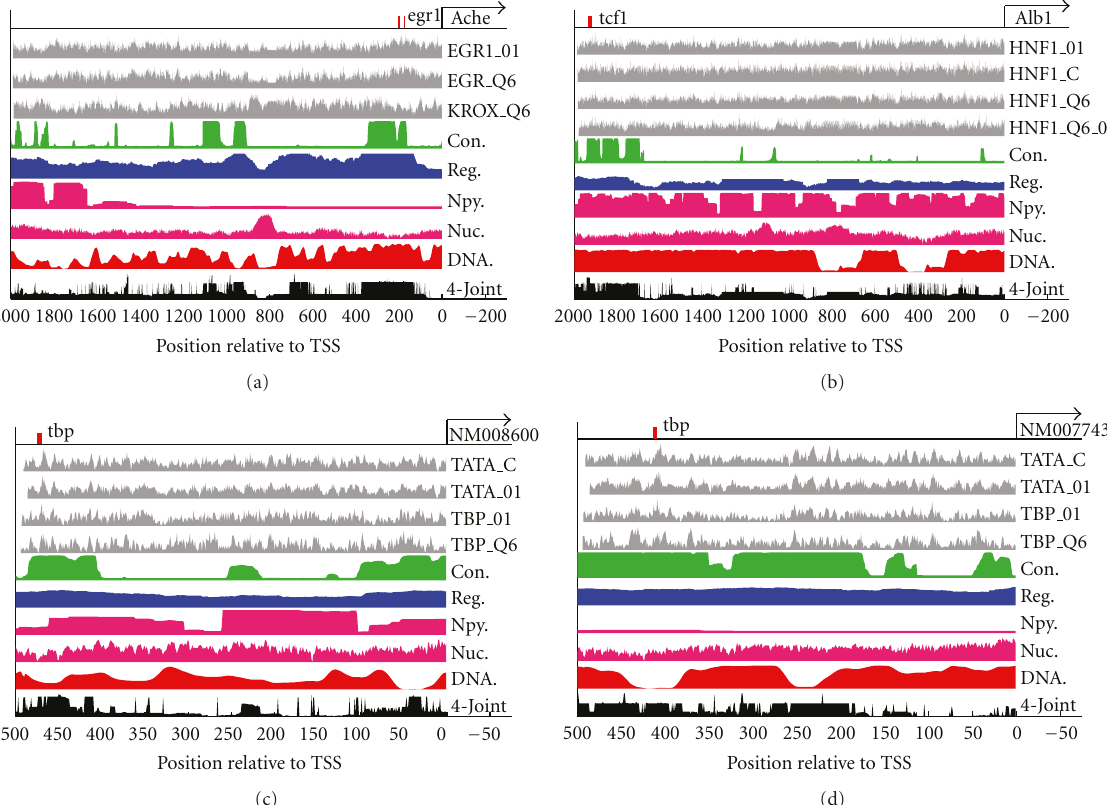
Figure 1: Illustration of data fusion problem in TF target gene prediction. The promoter sequence names are shown above the arrow, and the arrow corresponds to transcription start site (TSS). Horizontal axis corresponds to position relative to TSS. The red bar(s) together with a TF name on the first line of each figure represent the known binding site. For a given TF, data shown in grey (named with TRANSFAC IDs) represent models corresponding to di ff erent position-specific frequency matrices (PSFM) that are found from the TRANSFAC database. Evolutionary conservation (green), regulatory potential (blue), two nucleosome positioning signals [1, 2] (magenta), and DNA duplex stability data (red) are shown in the following five rows (abbreviated with con., reg., npy., nuc. and DNA., resp.). The joint prior from all the four additional data sources (black) is shown in the last row. TFs shown in panels (a) and (b) are assumed to bind to their corresponding sequences in a double-strand manner, while TFs in panels (c) and (d) bind in a single-strand manner. All plotted data are for mouse